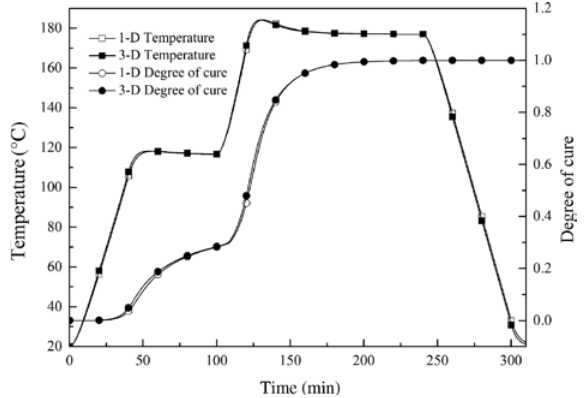
Figure 11: AGS composite structure.